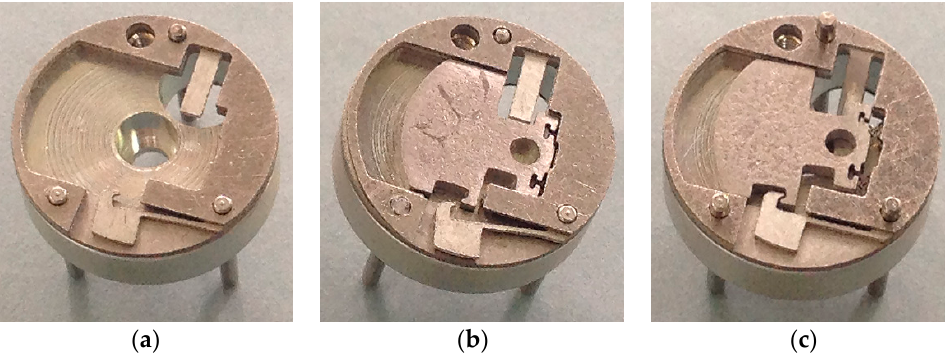
Figure 10. The states of arming mechanism under the different conditions. ( a ) 34,000 rpm and the electric thruster does not work; ( b ) 36,000 rpm and the electric thruster does not work; ( c ) 50,000 rpm and the electric thruster works. Table 3. The ultimate rotary speed of the micro S & A module arming. Group